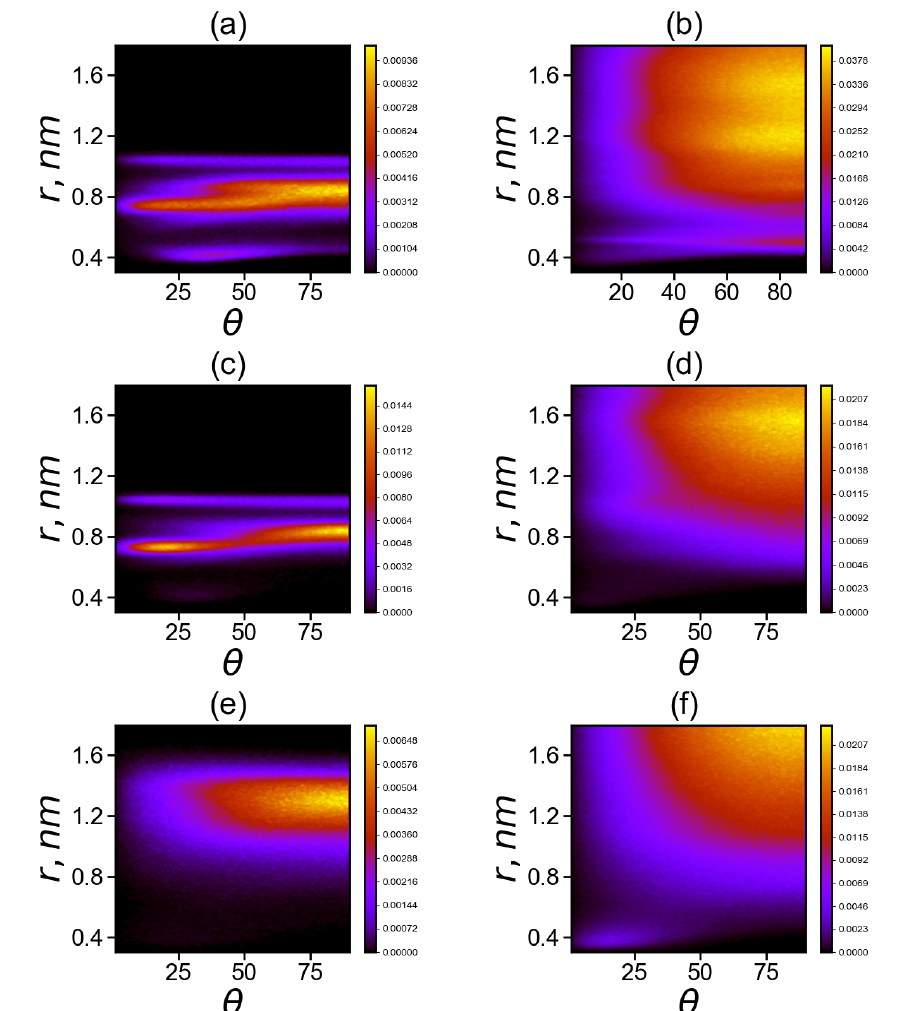
Figure 10. Two-dimensional maps of the distribution matrix N pairs (with matrix elements N pairs ( θ , r ) ) of imidazole–imidazole (or guanidine–guanidine) groups at T = 310 K ( a , c , d ) for pairs between neighboring groups and ( b , d , e ) for pairs between non-neighboring groups in Lys–2His ( a , b ), Lys– 2Hisp ( c , d ) and Lys–2Arg ( e , f